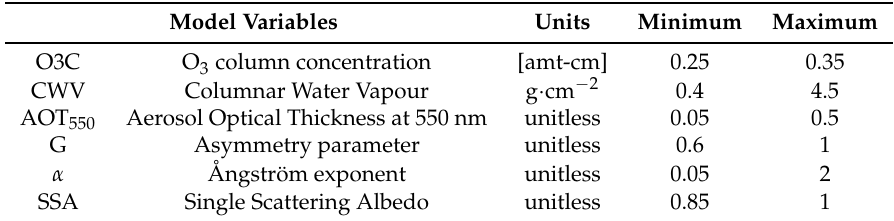
Table 3. Range of MODTRAN input variables for the analysis dataset according to Latin Hypercube sampling. MODTRAN fixed geometric variables: solar zenith angle: 30 ◦ ; viewing zenith angle: 0 ◦ . Remaining MODTRAN parameters were set to their default values.